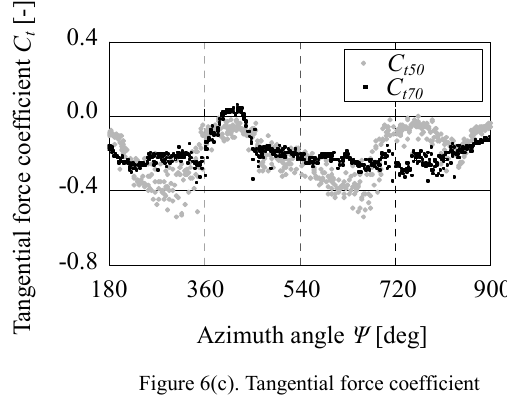
Figure 6(c). Tangential force coefficient